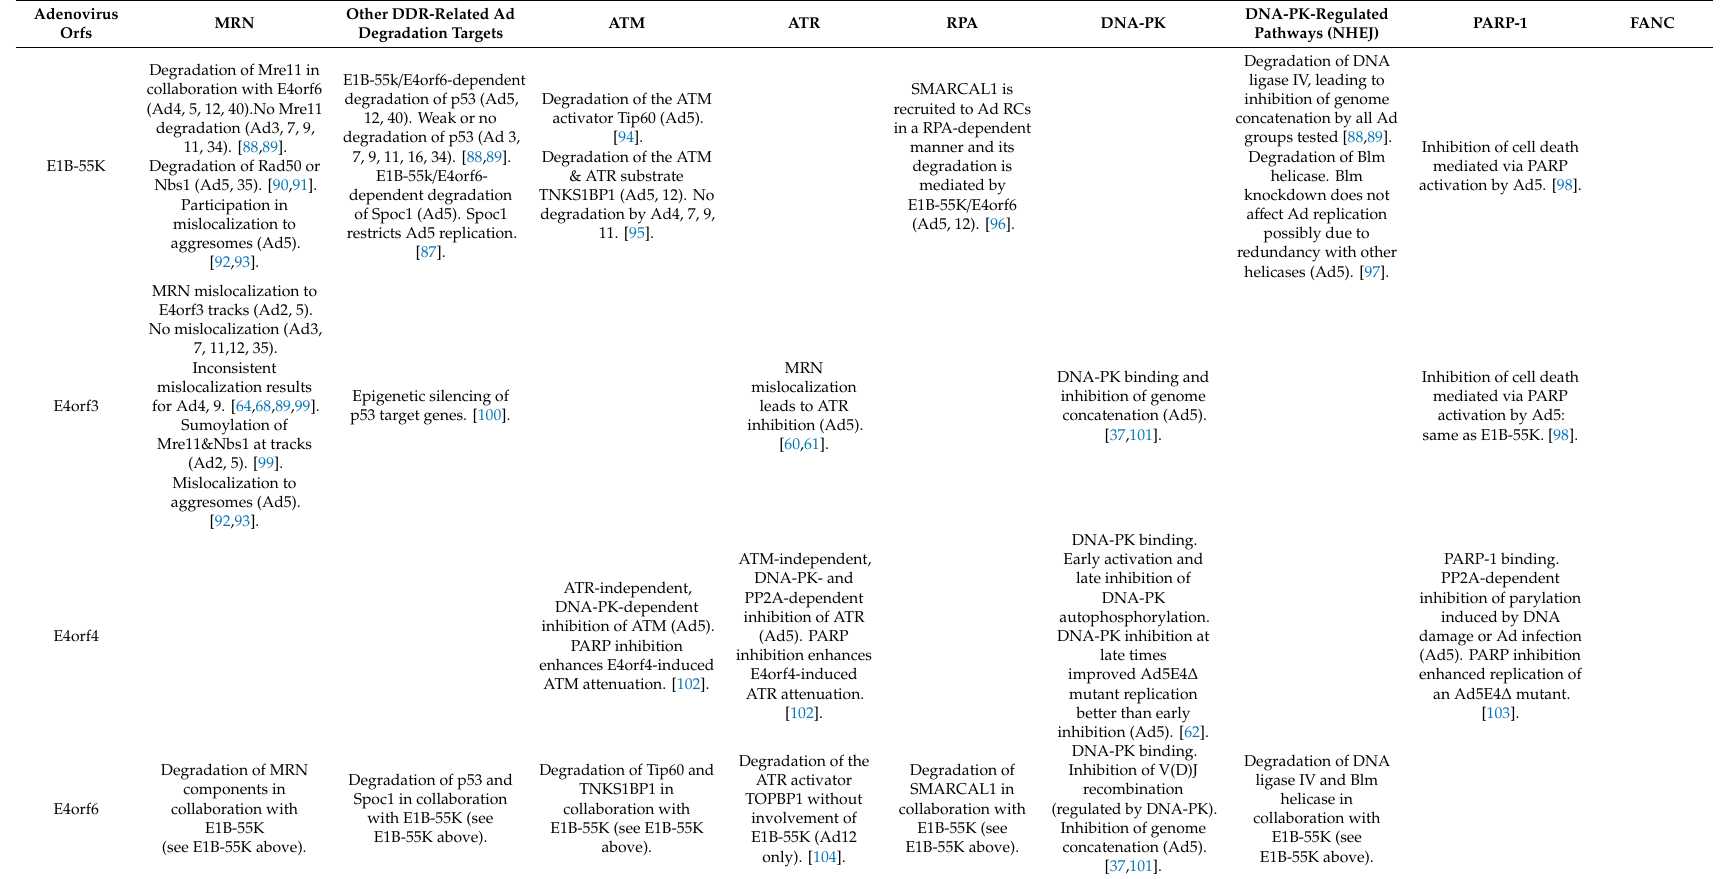
Table 1. Targeting DDR proteins by various orfs of multiple Ad